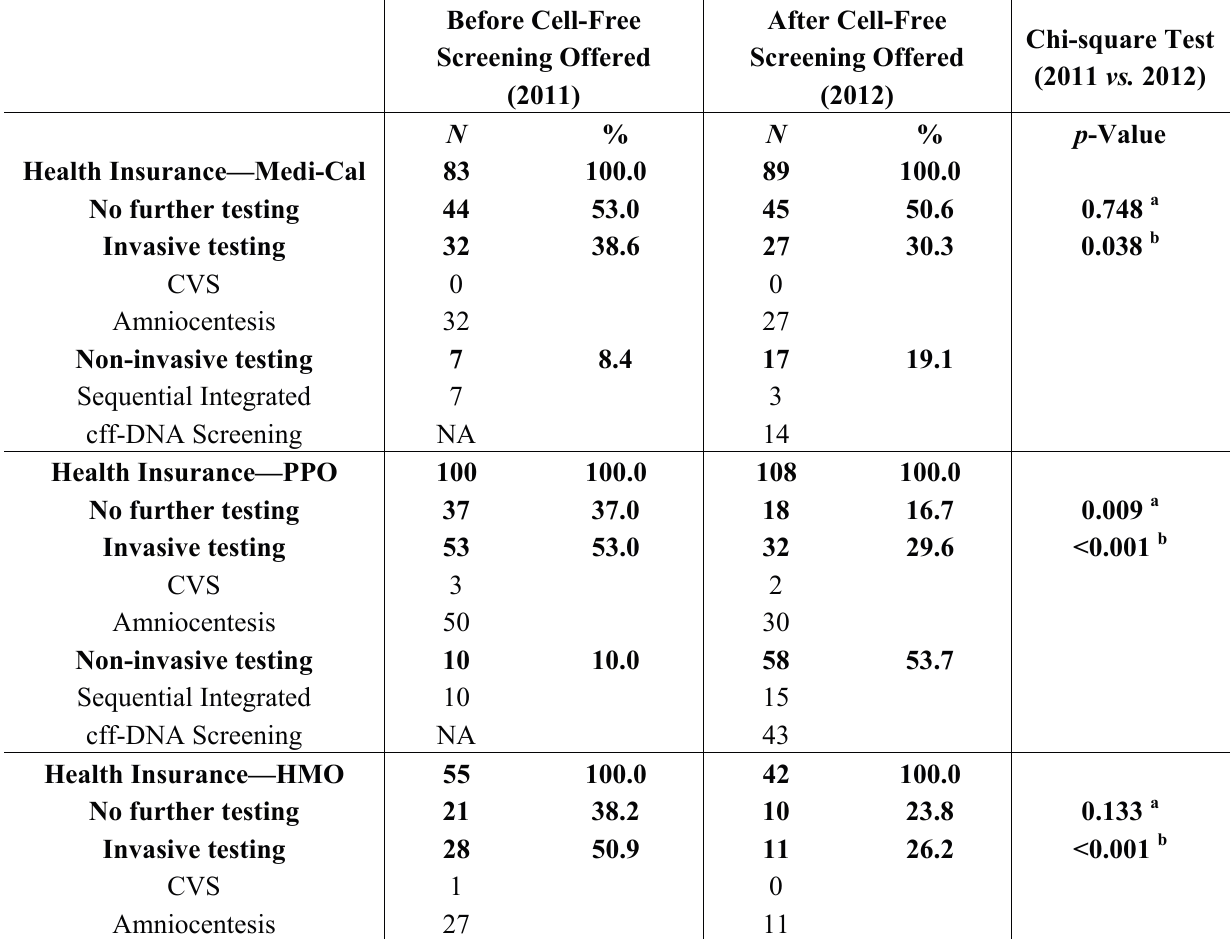
Table 4. Cell-free fetal DNA screening impact on testing chosen by health insurance.